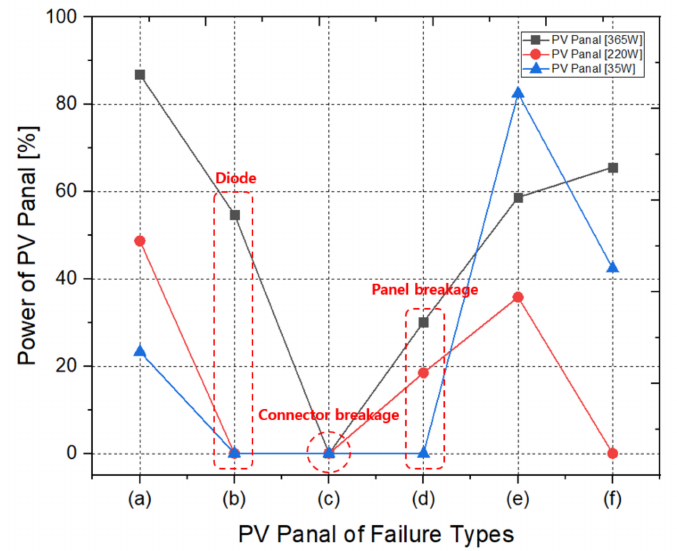
Figure 9. Output comparison of each PV panel by failure